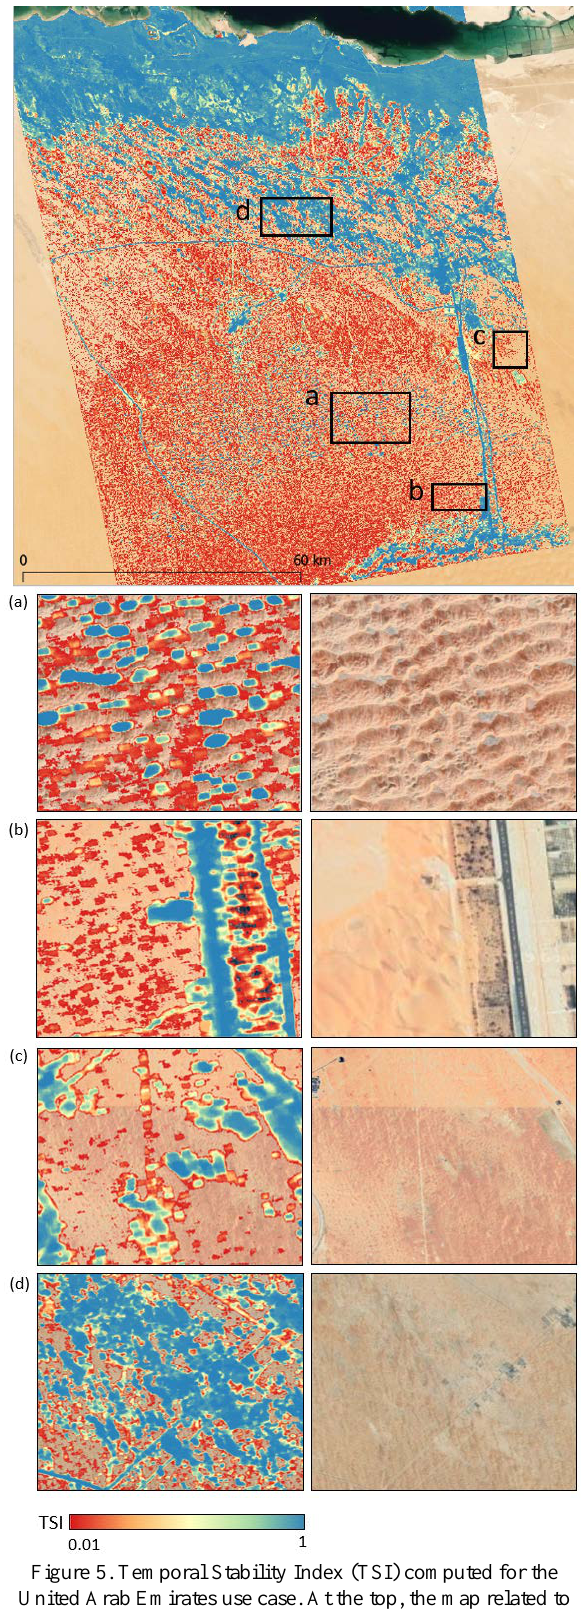
Figure 5. Temporal Stability Index (TSI) computed for the United Arab Emirates use case. At the top, the map related to the whole region of interest is proposed (© ESRI satellite Copyright). For each sub-area highlighted in the Figure, the TSI and the Google satellite optical image is presented (© Google 2019